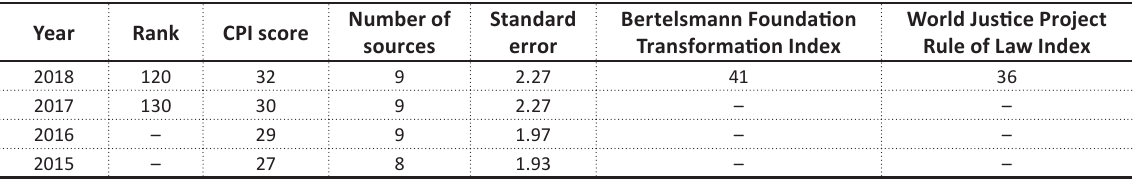
Table 1. Indexes of Ukraine in the World Corruption Perception